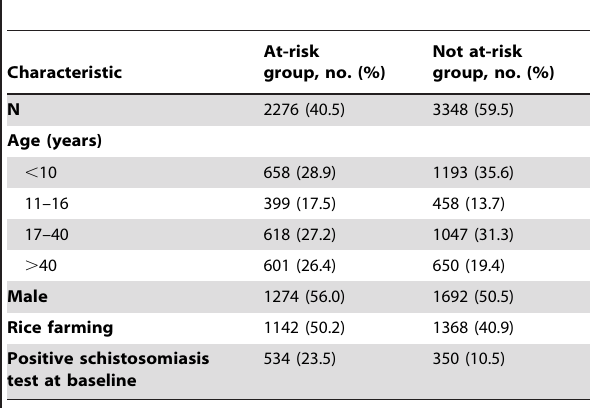
Table 1. Characteristics of the individuals in the ‘‘at-risk’’ and ‘‘not at-risk’’